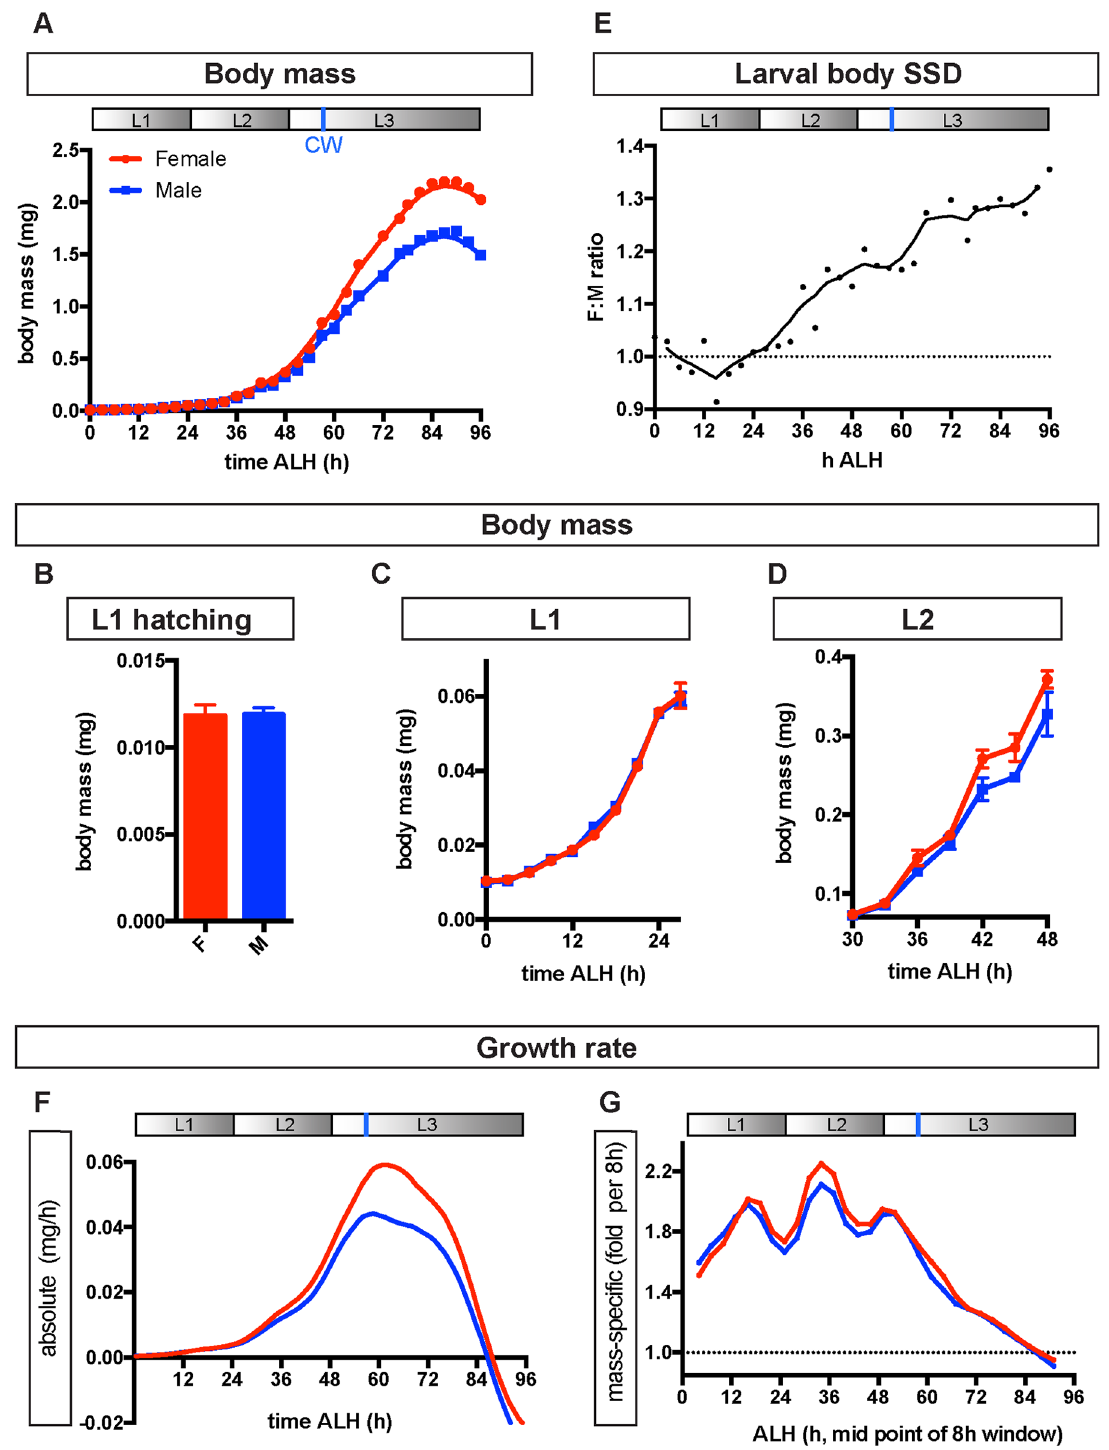
Fig 1. Physiological parameters underlying sexually dimorphic growth. (A–D) Growth curve of male and female larvae throughoutlarval development, showingthere is no sex difference in the overall growth period(A), body size at larval hatching (B), or duringL1 (C), with a difference in body size first apparentduringL2. Graph in (A) shows raw body mass measurements at each time point (dots) and a line of best fit (locally weightedscatterplot smoothing[LOWESS] curve). (E) Ratio of female to male (F:M) body mass duringlarval development calculatedfrom time-course data in (A). Individual points show F:M ratios